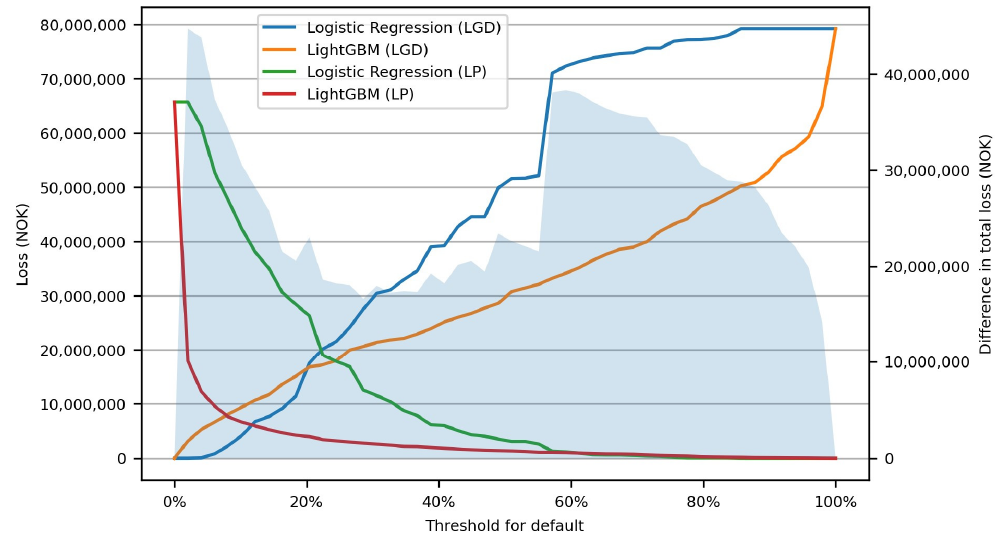
Figure 15. Approximated costs for imperfect credit scoring models. The x -axis indicates the threshold for default, whereas the left y -axis indicates potential losses. The shaded area displays the difference in total loss between Logistic Regression and LightGBM and is measured on the right y -axis. Loss given default (LGD) and lost profits (LP) are plotted, for both LightGBM and Logistic Regression.